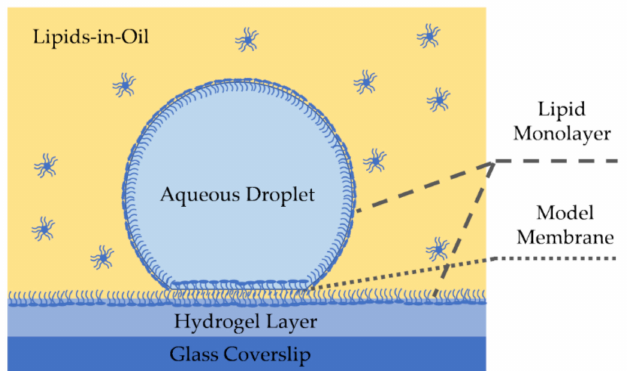
Figure 5. Side view of a droplet on hydrogel bilayer, or a membrane formed at a water-hydrogel interface in an oil medium. Here a hydrogel layer and a water droplet are submerged in a lipid- dispersed oil solution and the amphiphilic molecules self-assemble at the oil-hydrogel and at the oil-water interfaces forming monolayers. Placing the aqueous droplet on the hydrogel surface enables membrane